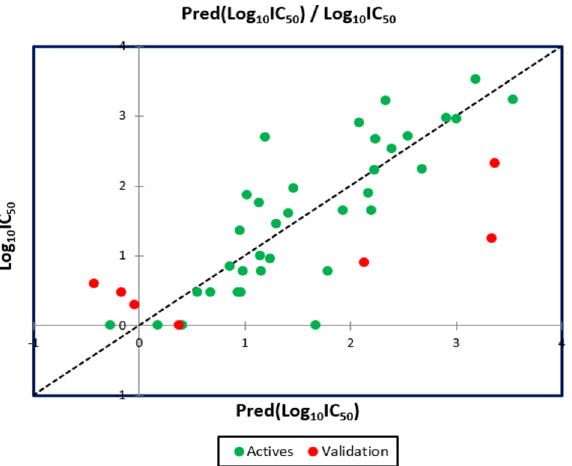
Figure 5. Correlation between the observed and predicted activities using MNLR technique.